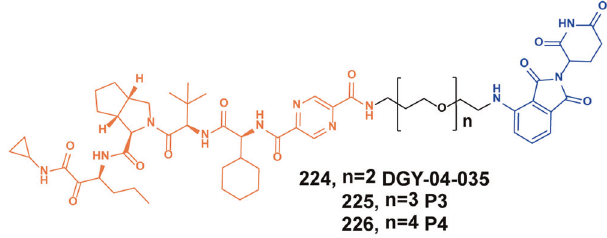
Fig. 74 The representative PROTACs targeting